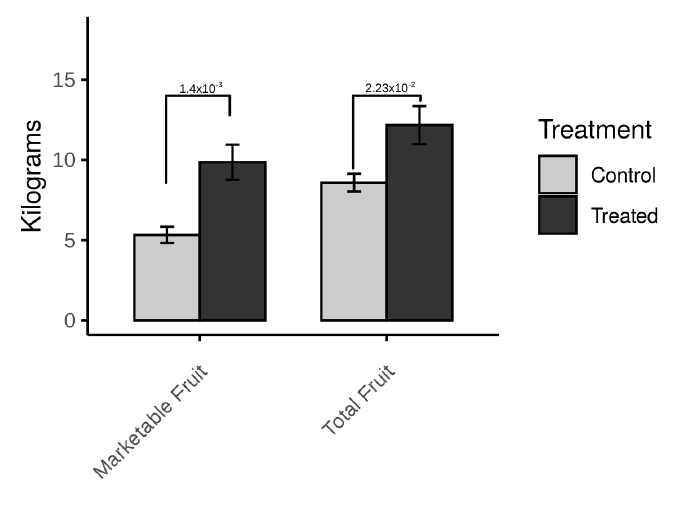
Figure 6. Total fruit and marketable fruit per vine in treated and untreated blocks as measured at the end of the trial. Poisson regression followed by Wilcox test was used to determine statistical di ff erence between treated and untreated vines and p values are presented above the bars. N = 25